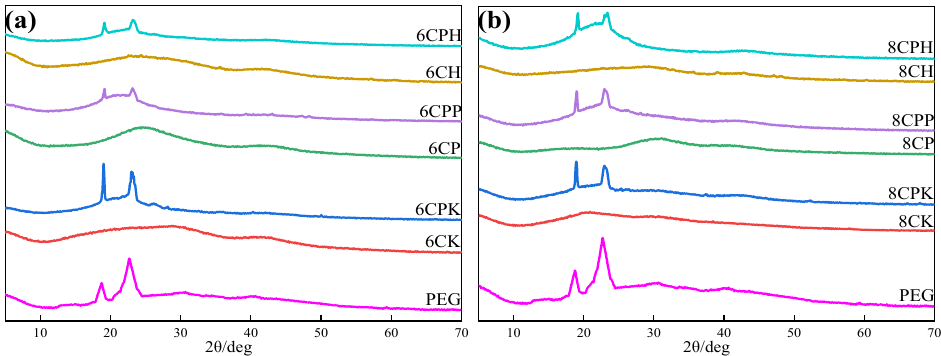
Figure 3. XRD spectra of PEG, carbon materials, and composites under different temperature activation. ( a ) 600 °C, ( b ) 800 °C.